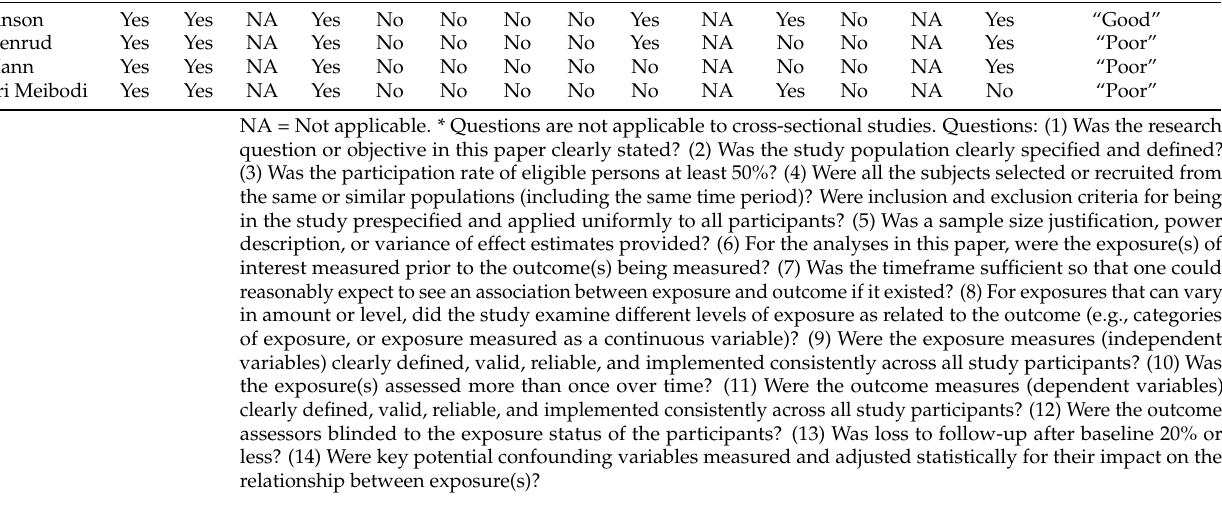
Table 1. NHLBI Risk of Bias Table for Cross-sectional and cohort studies. Question Number